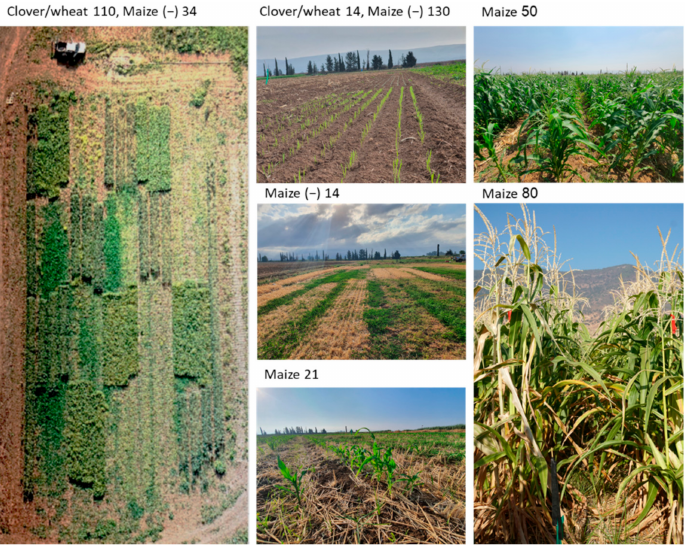
Figure 10. The field experiment—representative photos from the air (on the left ) and the ground (on the right ). The field trial is described in Figure 2. Numbers indicate days from